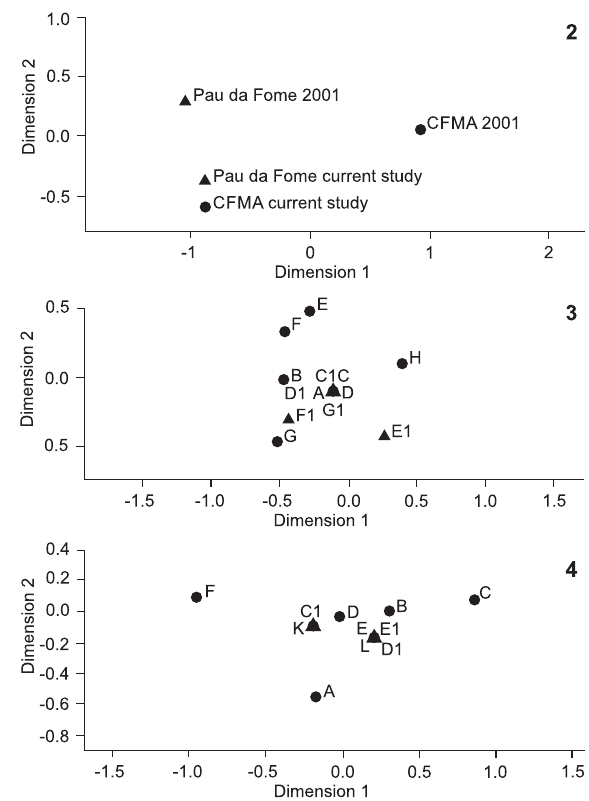
Figures 2–4. Plots of the Non-metric Multidimensional Scaling Analysis between the two periods and areas studied ( ● CFMA and  Pau da Fome) for the small mammal species: (2)